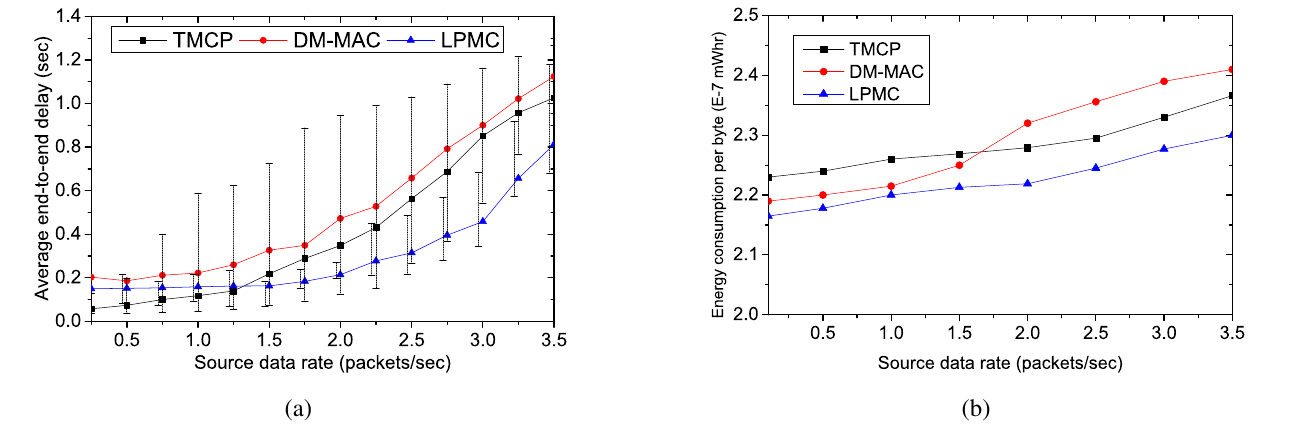
Figure 9. Impact of channel quality and external interference on the performance: (a) average end-to-end delay (The vertical lines shows the minimum and maximum delays for different channels), (b) energy consumption per delivered byte. All nodes send data to the